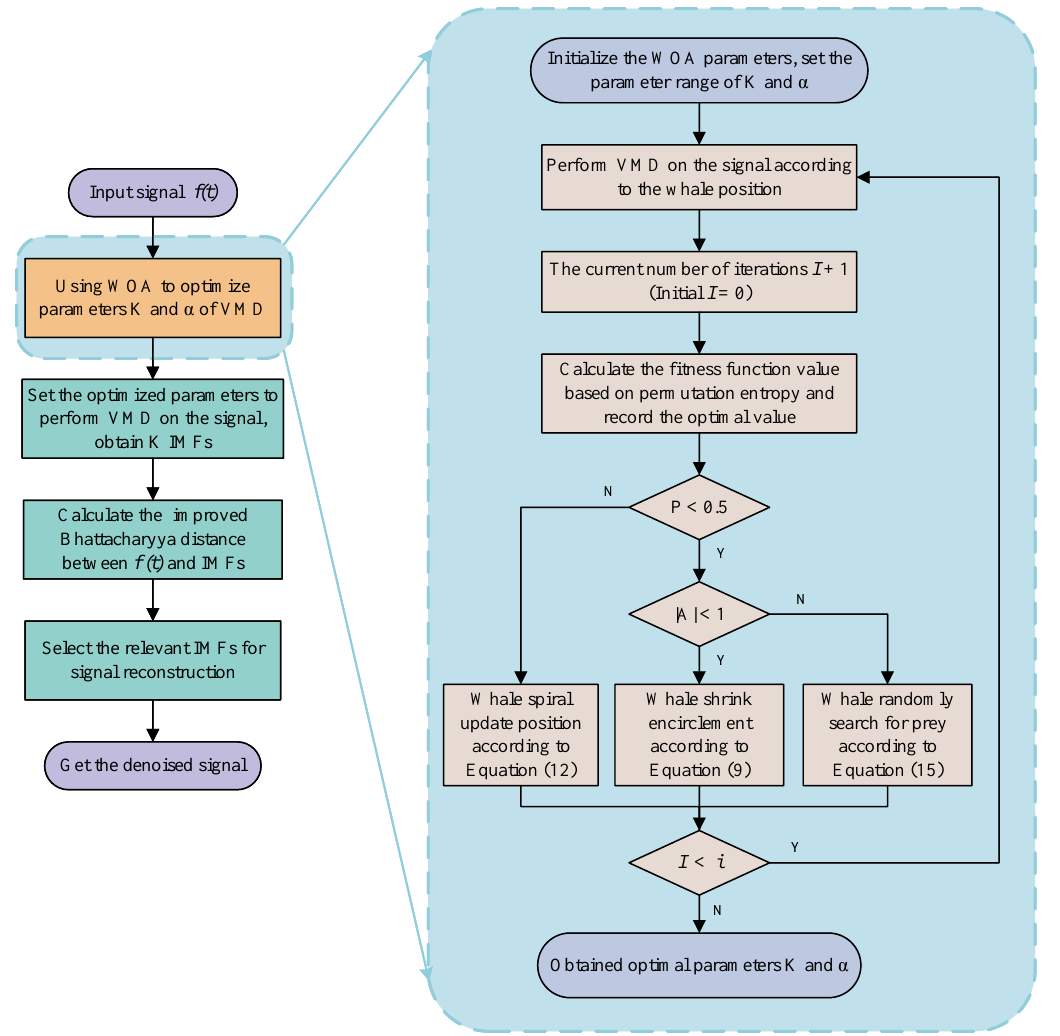
Figure 1. Flow chart of signal denoising method based on